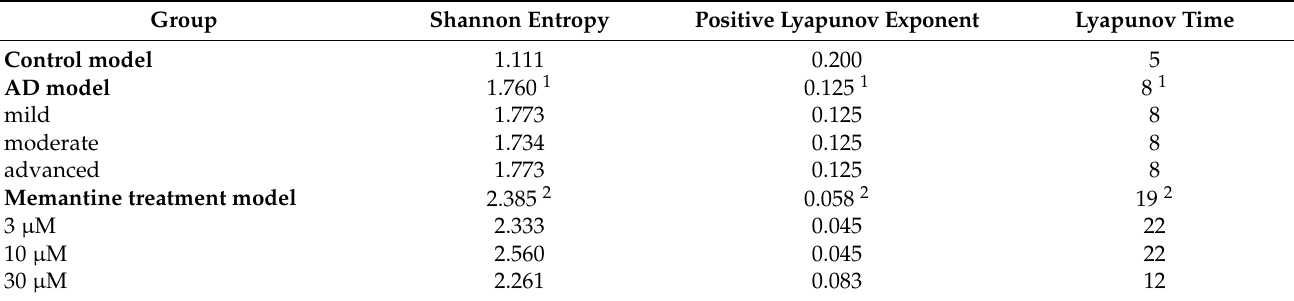
Table 1. Parameters in the complex system—neurodegenerative disease: Shannon entropy,